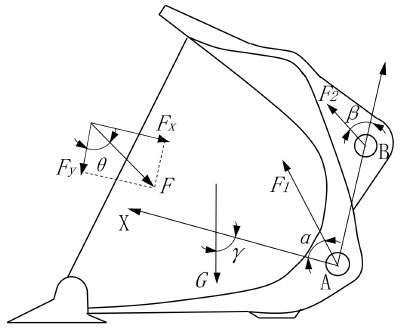
Figure 4. The force diagram of the left side of the